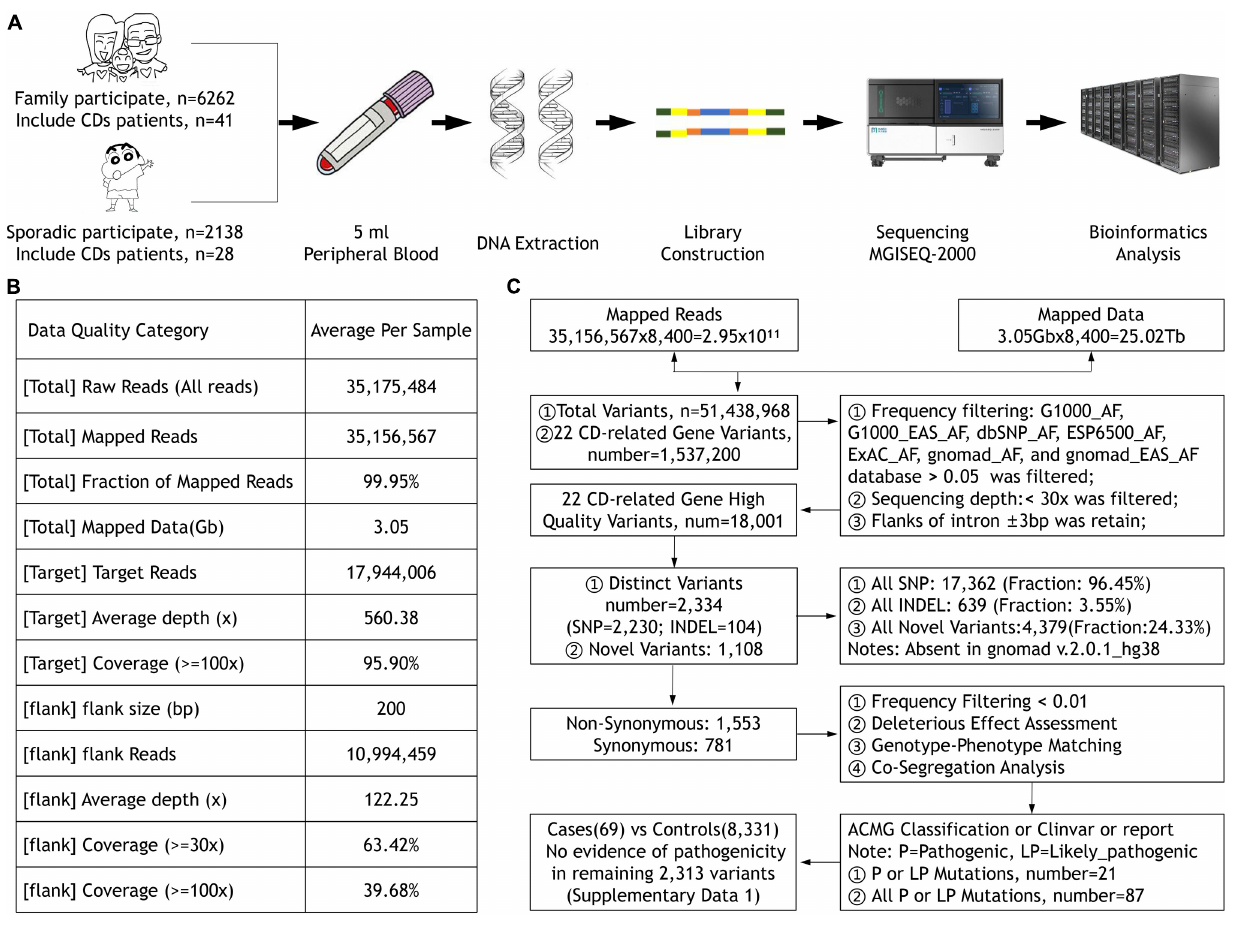
FIGURE 1 | (A) The sample collection, DNA extraction and detection, library construction, and sequencing process. (B) The quality of the data. (C) The workflow of data processing and